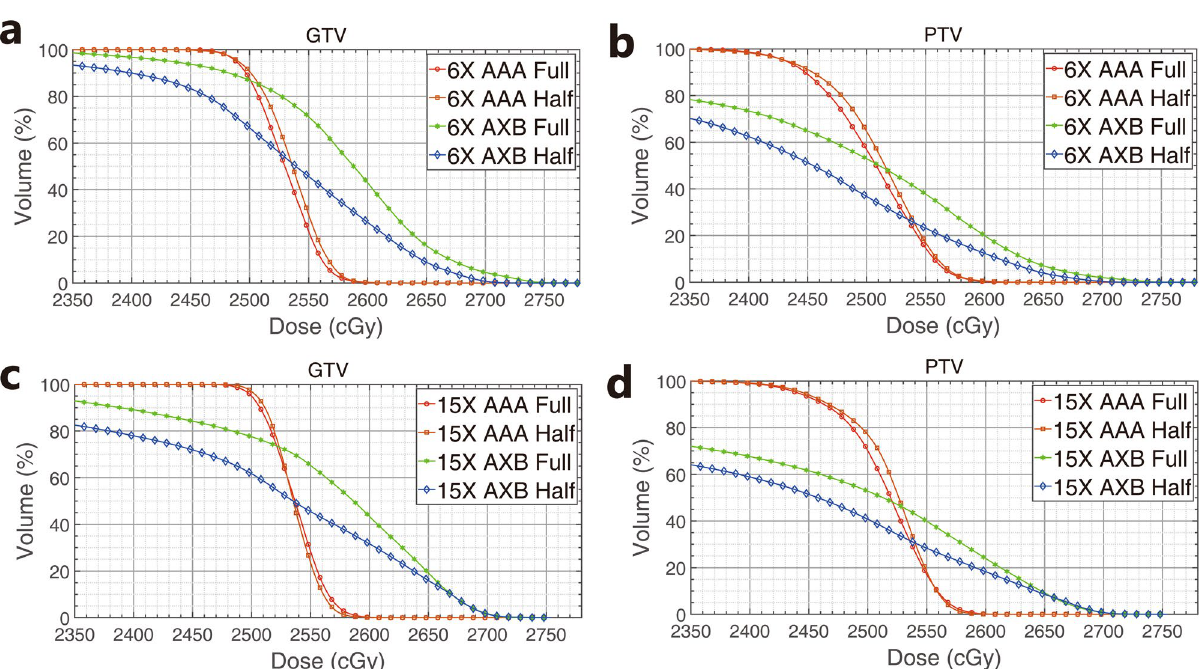
Figure 8. Dose-volume histograms for ( a ) GTV p in the 6-MV plans, ( b ) PTV_25 in the 6-MV plans, ( c ) GTV p in the 15-MV plans, and ( d ) PTV_25 in the 15-MV plans. Calculation Energy